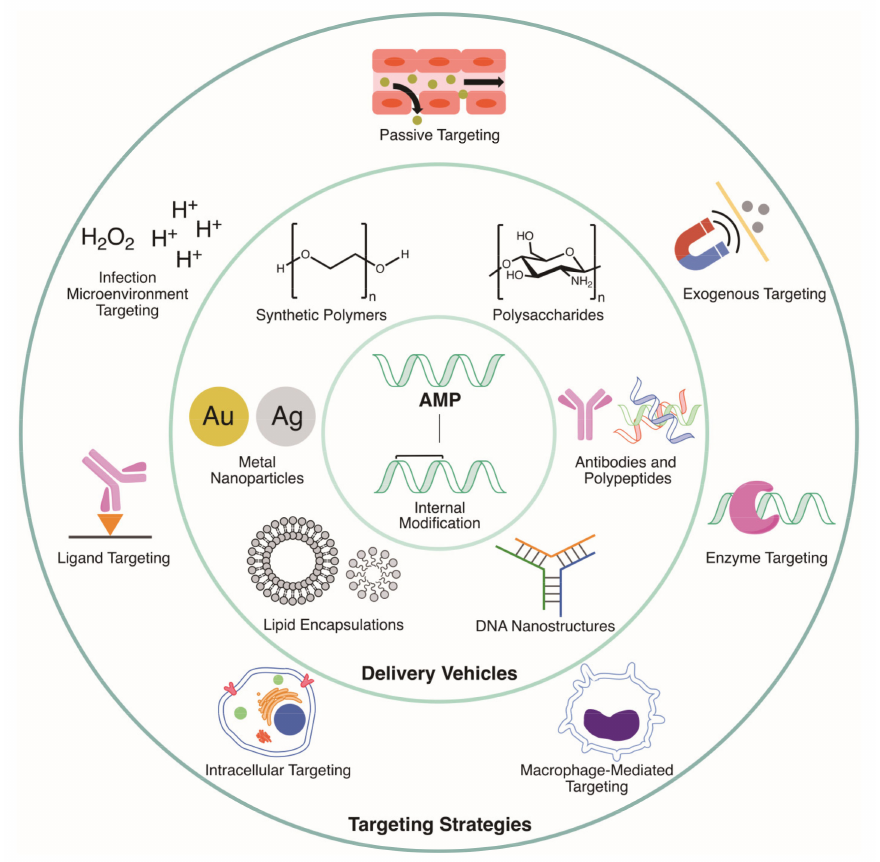
Figure 1. Summary of all of the targeting strategies, delivery vehicles, and AMP modifications presented in this